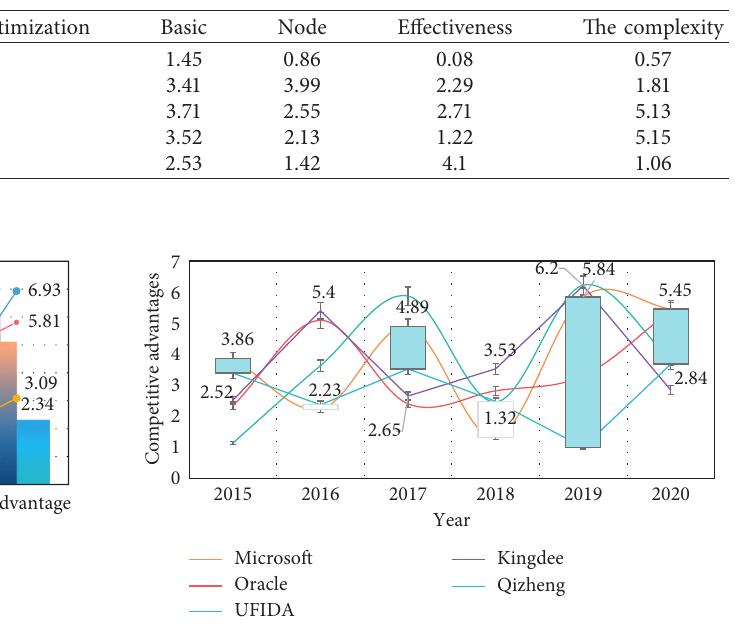
Table 7: Association of characteristic parts in complex systems.